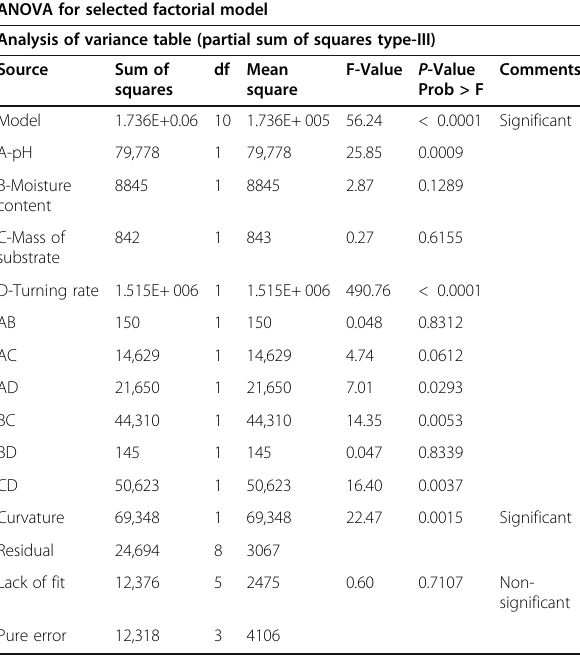
Table 7 Analysis of variance table for input variable screening ANOVA for selected factorial model Analysis of variance table (partial sum of squares type-III)